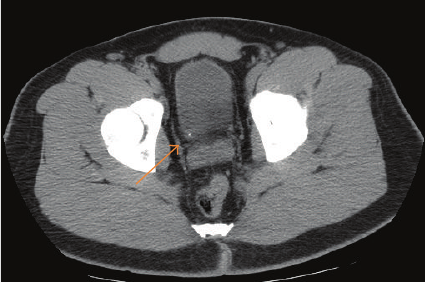
Figure 2: Right uretero-vesicular junction calculus (arrow) associ- ated with right hydroureter (not shown).